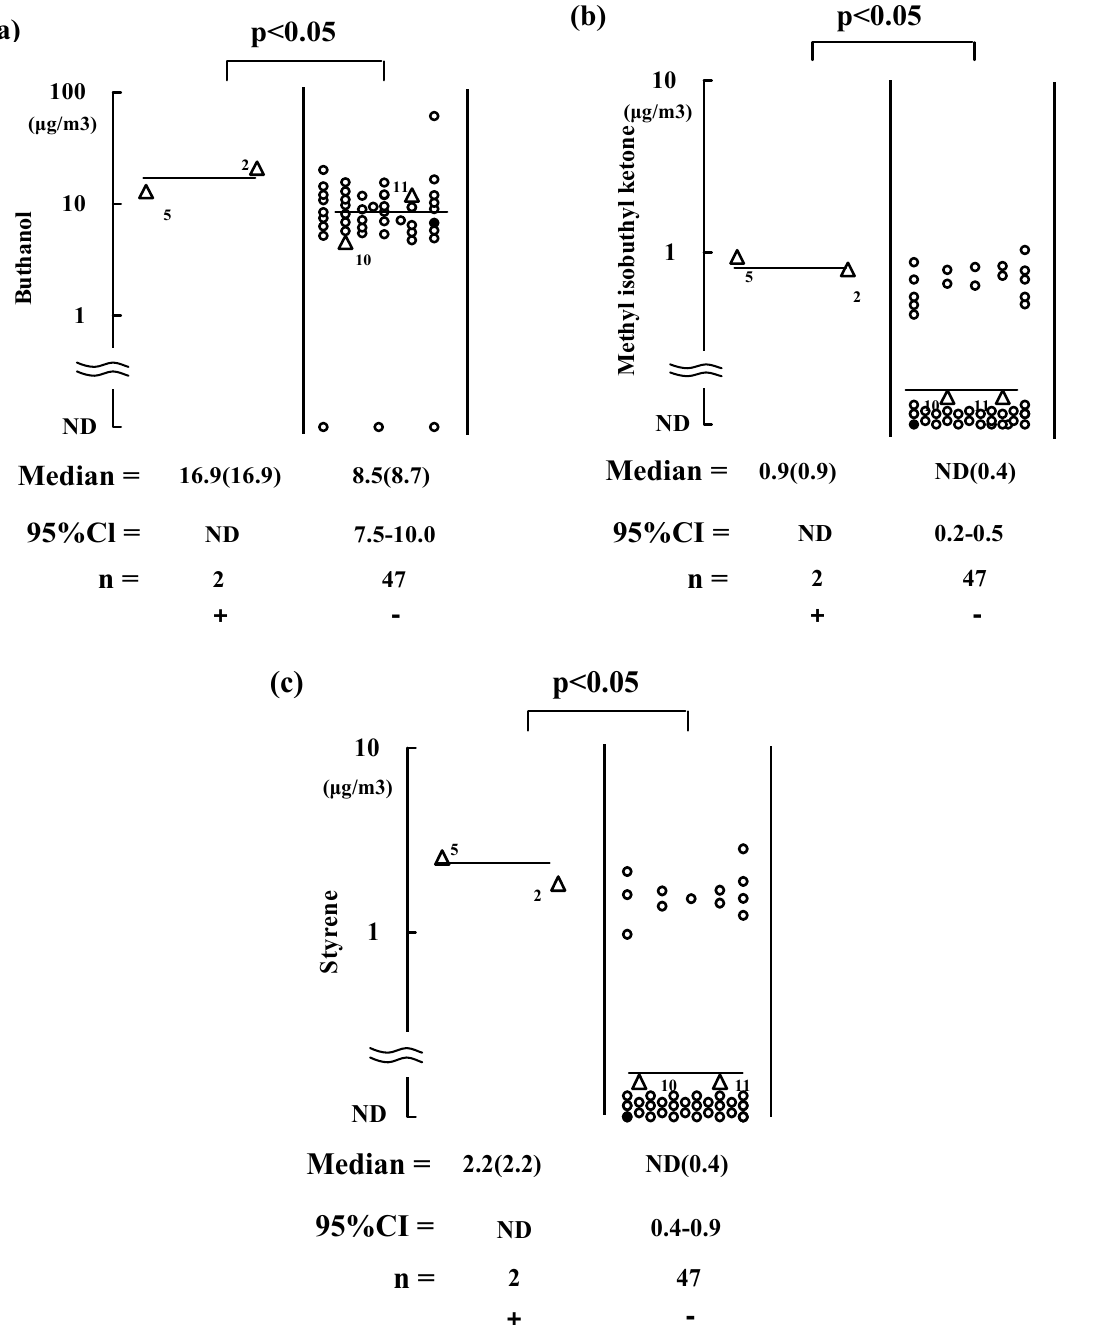
Figure 3. Air concentrations of butanol ( a ), methyl isobutyl ketone ( b ), and styrene ( c ) in kitchens. These values were compared between females with (+) and without ( − ) symptoms during the sampling. Symbols are specified in Figure 1. Bar = median value. Point estimation of median is in parenthesis; 95% CI = 95% confidence interval. ND = not determined because of the small number of